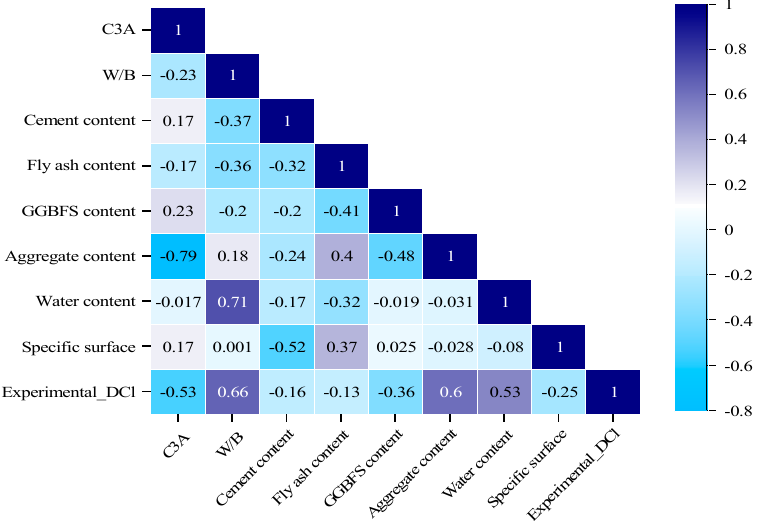
Figure 1. Correlation matrix of the variables.